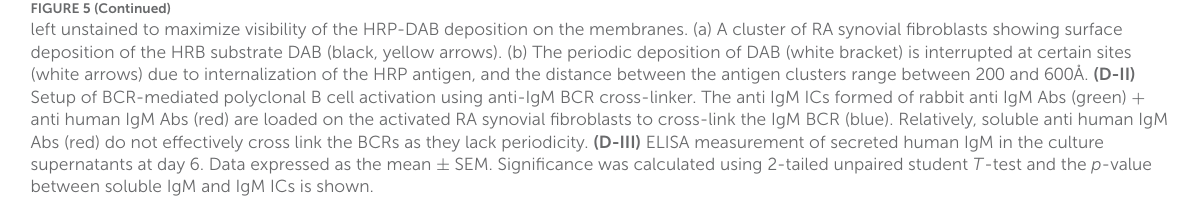
TABLE 3 Correlation of synovial tissue and blood CXCL13, TNF- α , LT- β with RA synovial pathotypes.